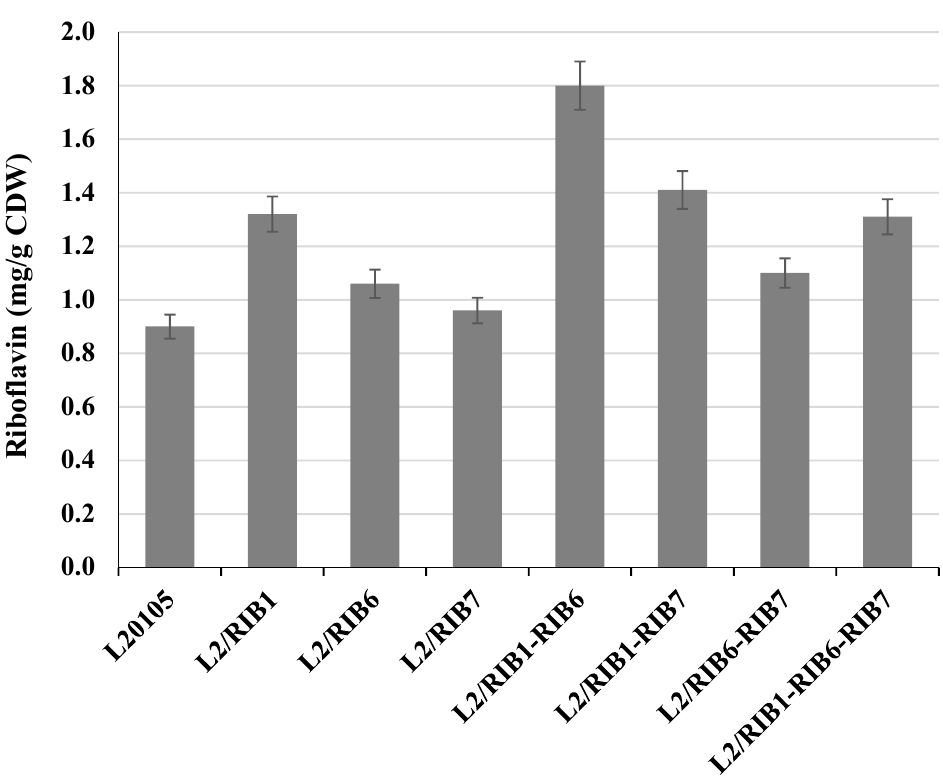
Figure 3. Riboflavin yield (mg/g CDW) of C. famata strains expressing RIB1 , RIB6 , and RIB7 genes in different combinations derivative of strain L20105 in the YNB medium on the third day of cultivation.